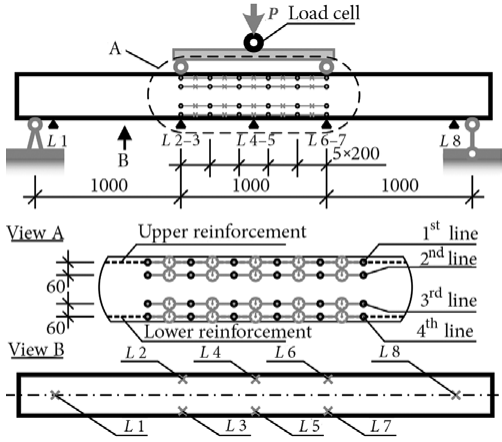
Fig. 3. Structural system and equipment arrangement of the full-scale